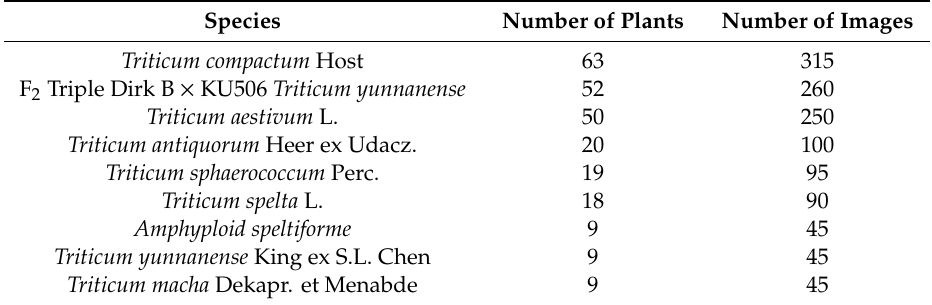
Table 2. Wheat species and hybrids used in prediction of spike density index and shape type. Species Number of